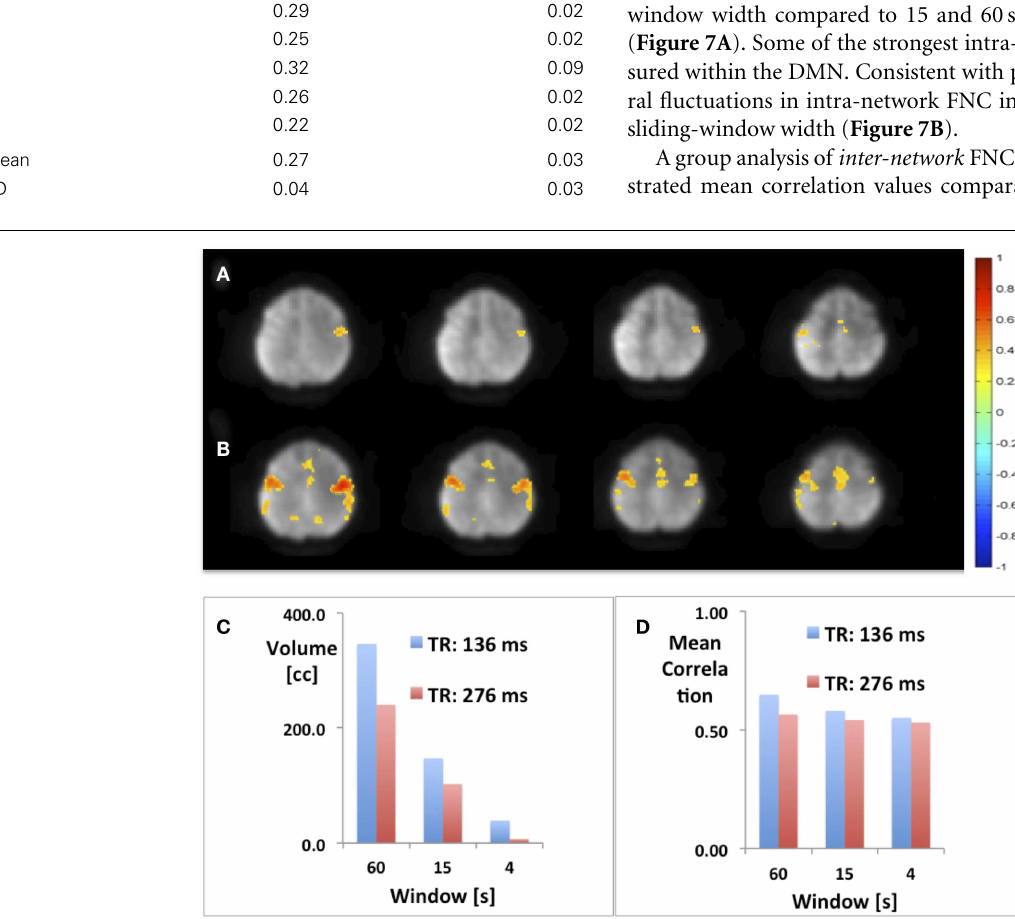
MEVI4 . (C) The spatial extent of connectivity decreases strongly with sliding-window width, but it is larger with MEVI2 compared to MEVI4 at all three time scales. (D) The mean correlation is comparable across the range of time